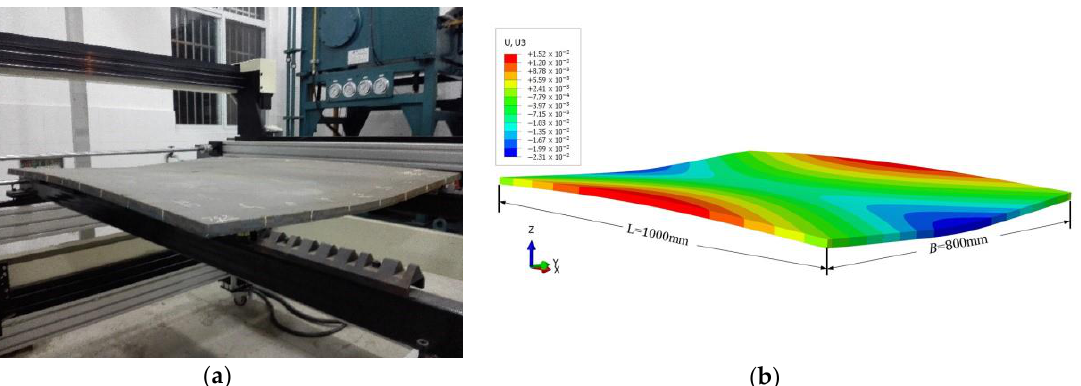
Figure 9. Plate deformation from the test and the finite element calculation: ( a ) test deformation and ( b ) calculated deformation.